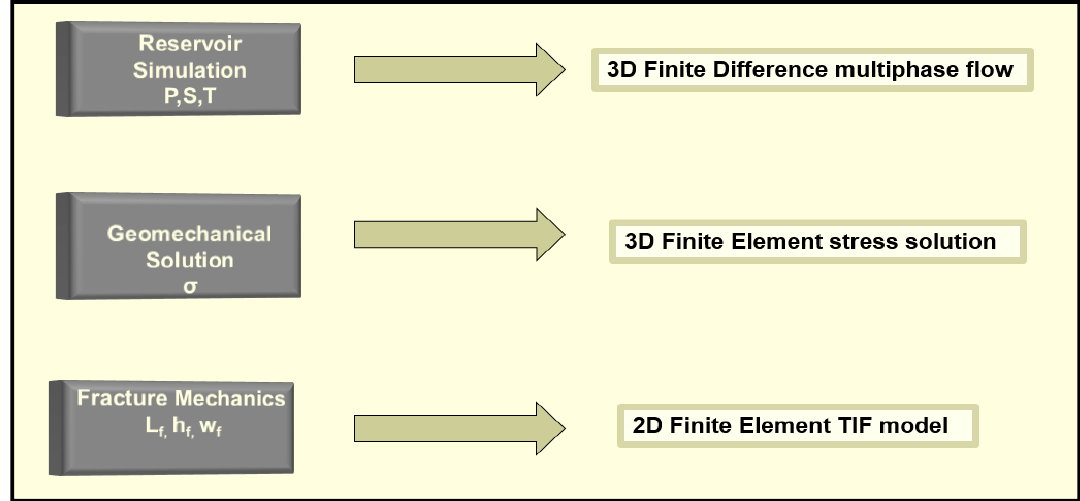
Figure 13. Solution methods used for each element of the coupled model.